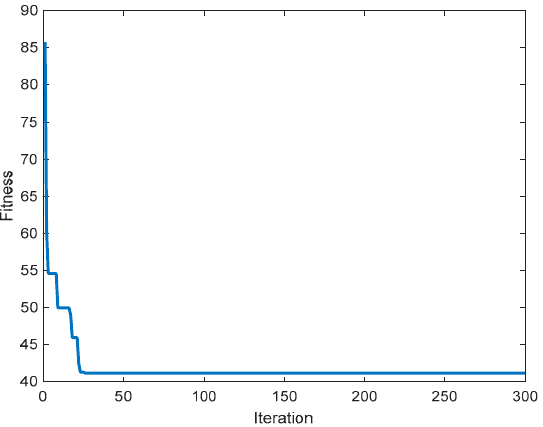
Figure 4. The convergence characteristics of the proposed method in case V.